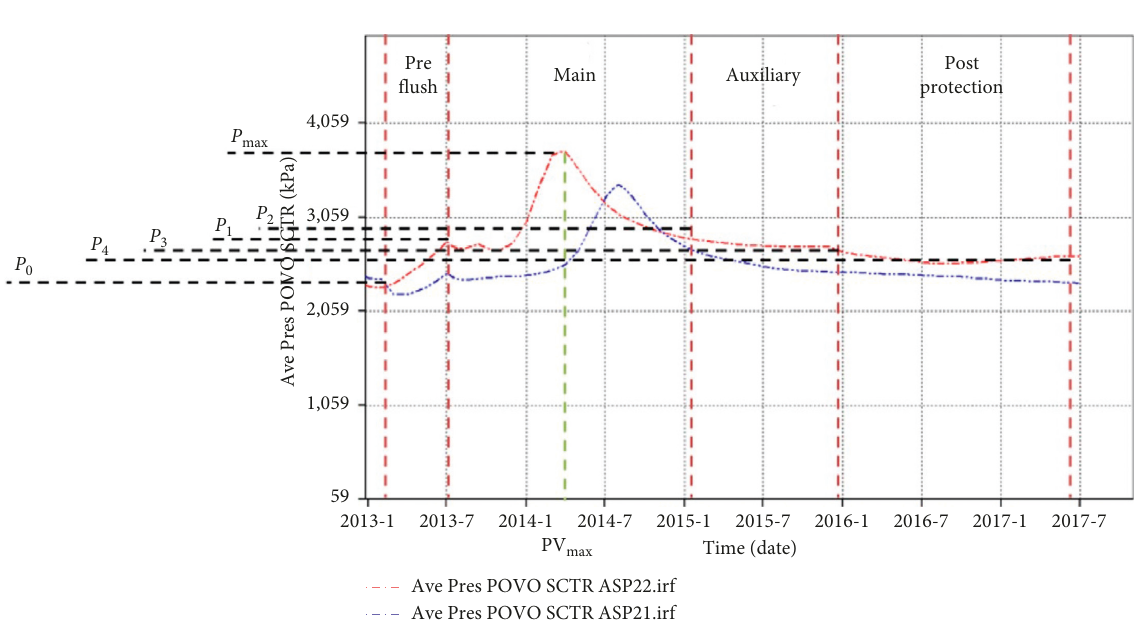
Figure 29: Objective pressure employed in